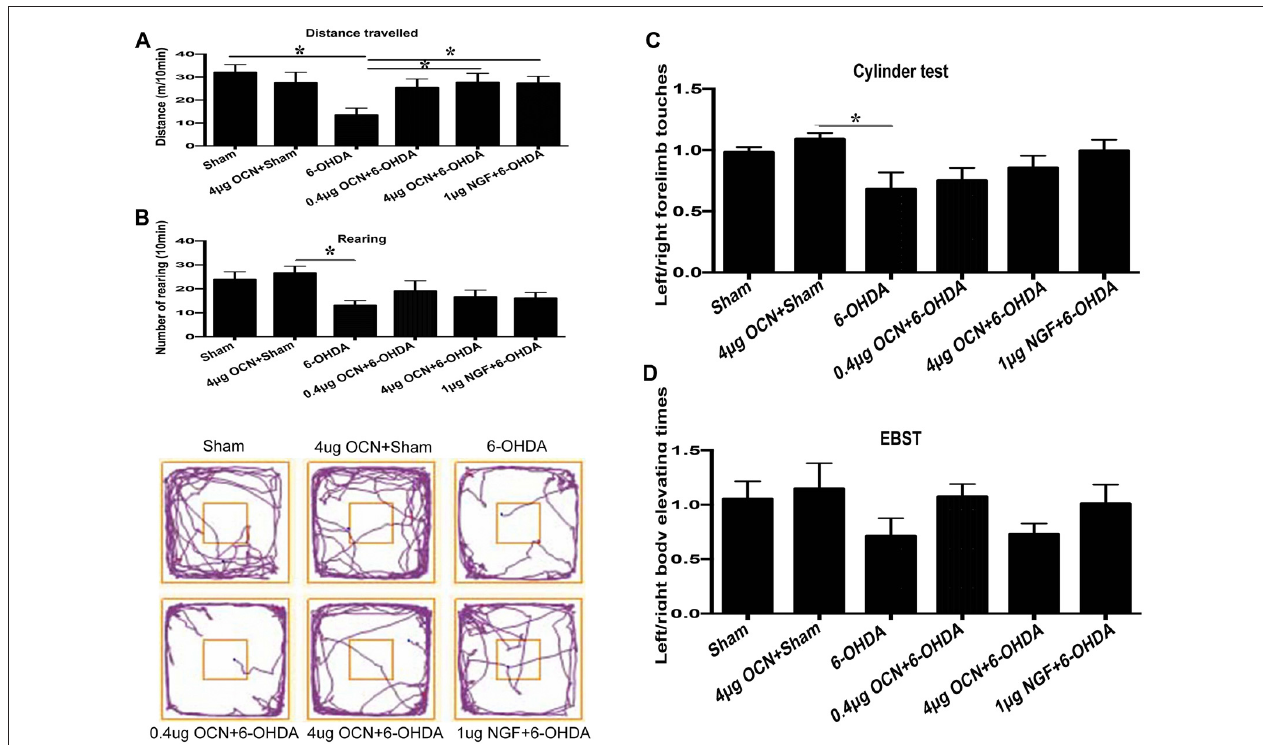
FIGURE 3 | Effect of intra-striatum injection of OCN on distance traveled (A) , rearing responses (B) in OFT. The cylinder test (C) and EBST (D) were used to evaluate locomotor asymmetry. Compared with the sham groups, 6-OHDA injection decreased the distance traveled by rats, while the injection of OCN (4 µ g) or nerve growth factor (NGF) significantly improved movement distance (A) , but not rearing impairment (B) of 6-OHDA-lesioned rats in OFT. The representative traces of the OFT are shown in the lower panel of (B) . No obvious differences were observed in the cylinder test (C) or the EBST (D) . n = 9–11, ∗ P < 0.05 (compared with the 6-OHDA